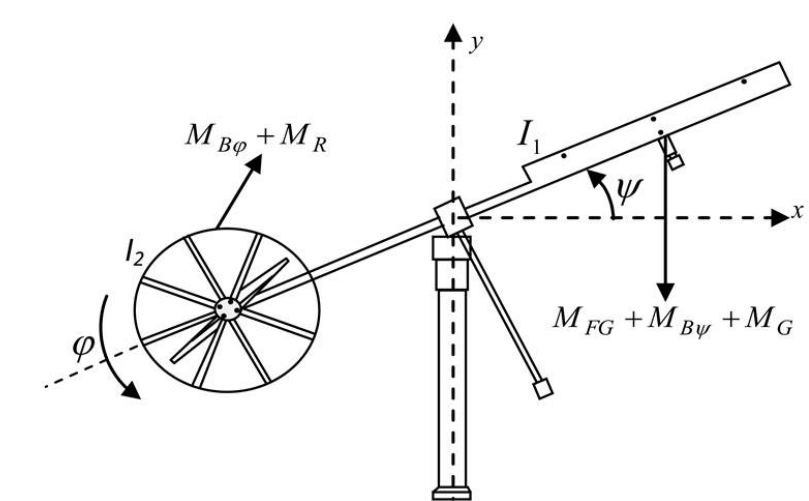
Figure 2. TRMS system